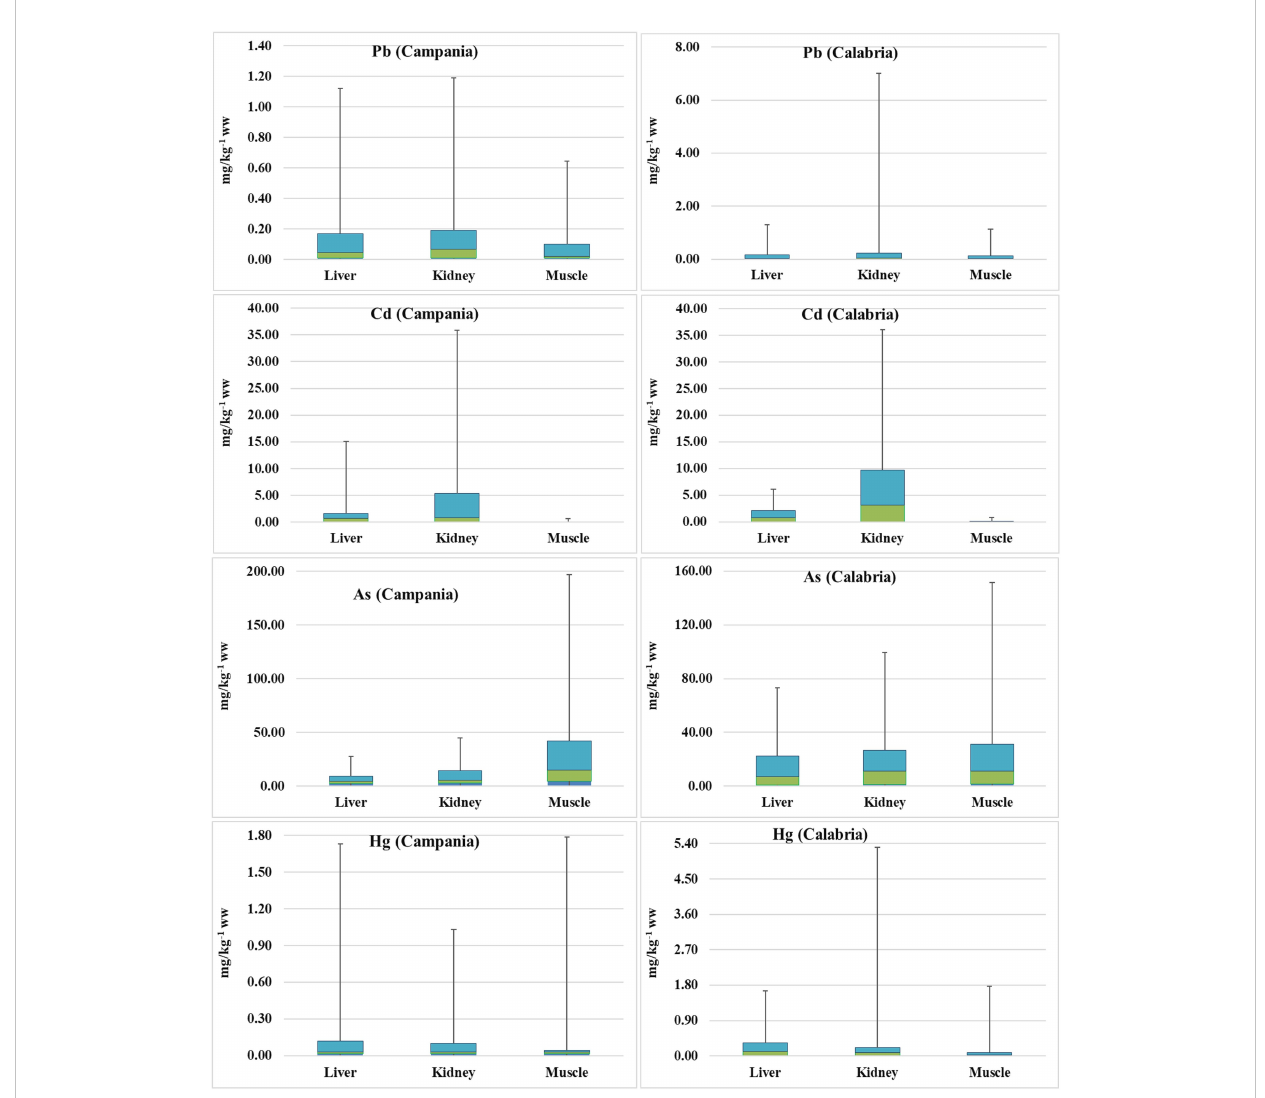
FIGURE 8 Box plots of As, Hg, Pb, Cd, and Pb concentrations (mg kg − 1 ww) in turtles. The lines in the middle of the box plots represent the